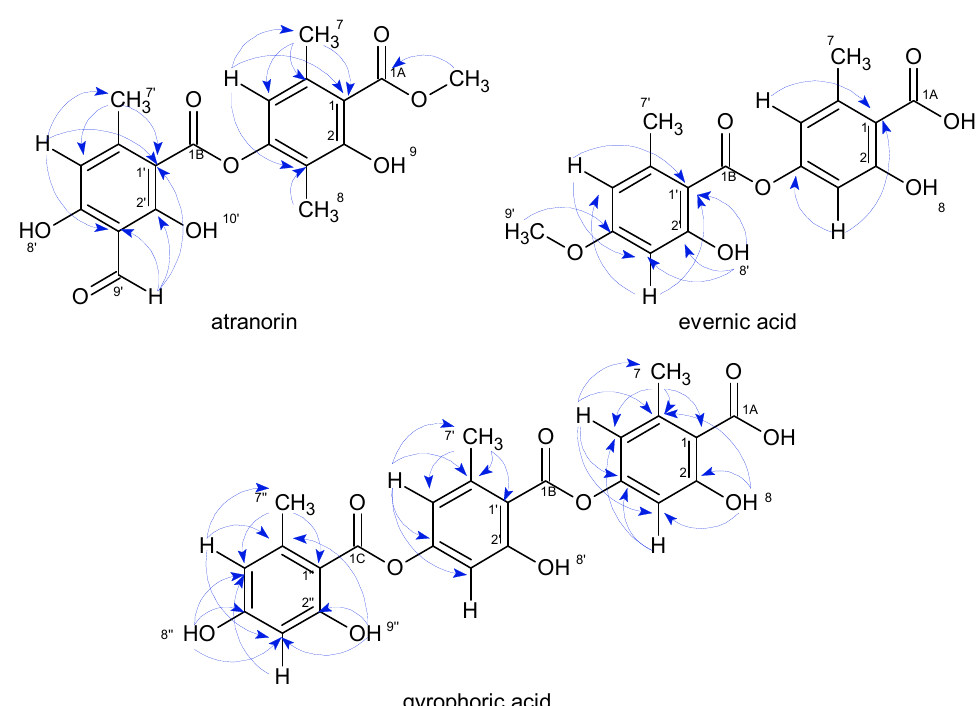
Figure 1. Chemical structures of depsides, atranorin, evernic acid, and gyrophoric acid along with their key HMBC correlations.